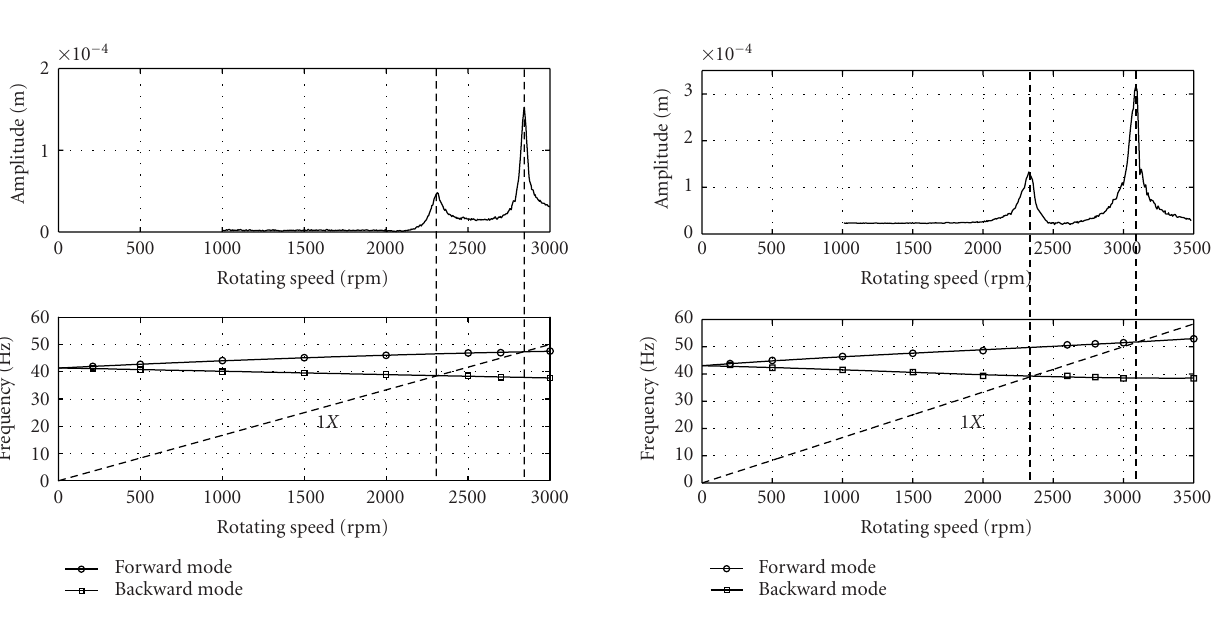
Figure 15: Unbalanced response for configuration B . Figure 16: Unbalanced response for configuration C